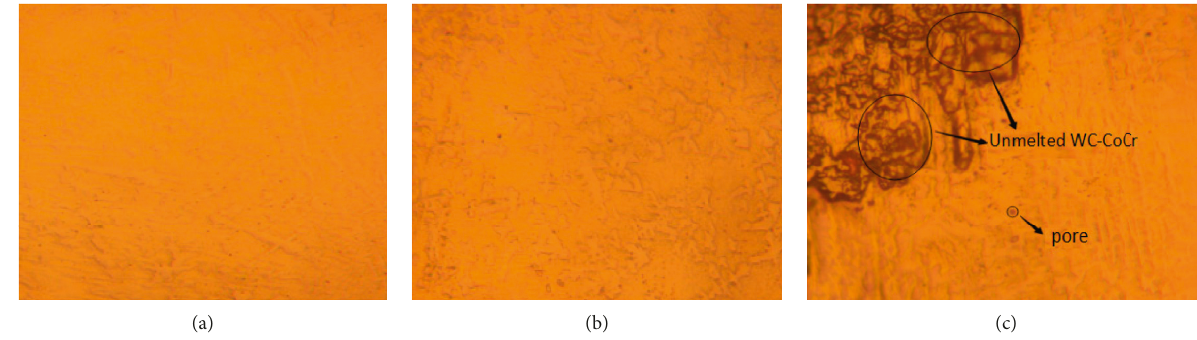
Figure 5: Microstructure of coating cross section with different scanning speeds: (a) 800mm/min, (b) 1000mm/min, and (c)